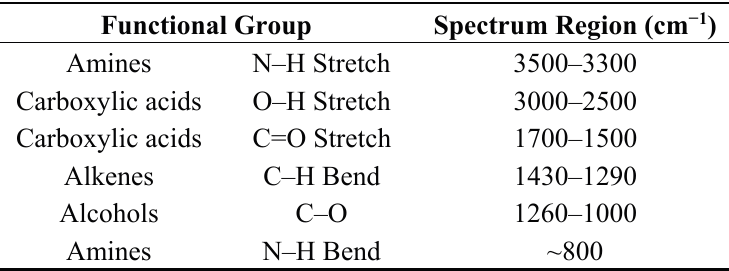
Table 3. Functional Group of FTIR